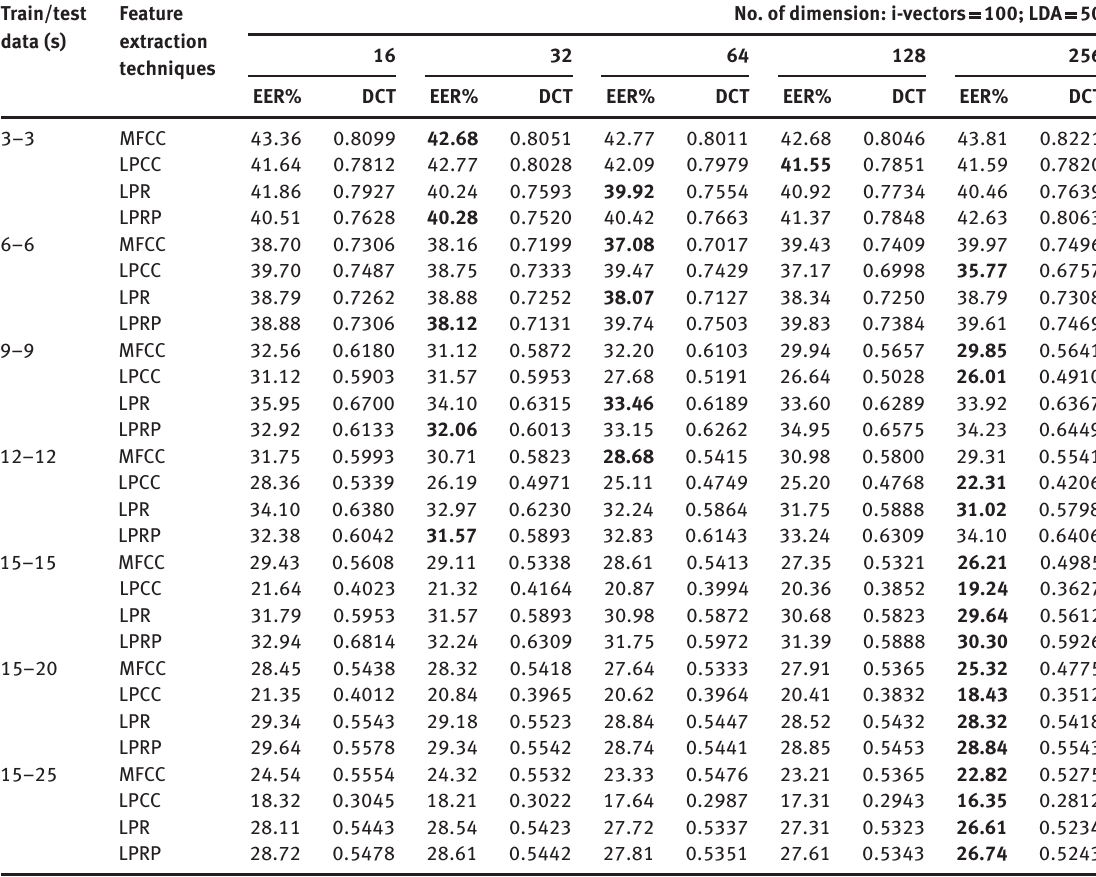
Table 2: EER of Speaker Verification for Using NIST 2003 Database for Different Feature Extraction Techniques (13 Dimensions) and Modeling Done by